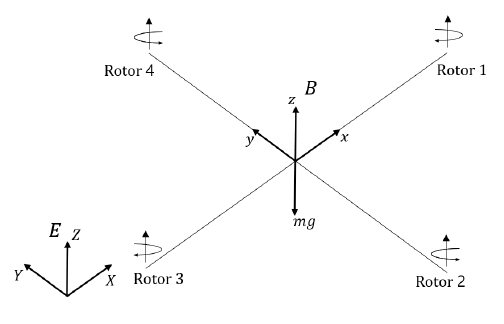
Figure 1. Quadrotor configuration frame system with body fixed frame B and inertial frame E